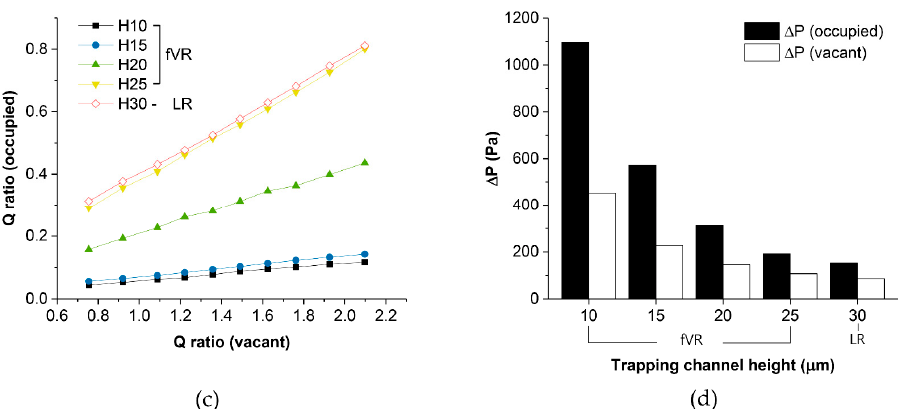
Figure 2. Computational analysis of the deterministic cell capture: ( a ) velocity field and streamlines of an LR-type and ( b ) an fVR-type; ( c ) Q ratio of the occupied trap sites regarding the Q ratio of the vacant trap sites for various trapping channel heights; ( d ) pressure difference across the occupied and vacant trapping channels for various trapping channel heights.